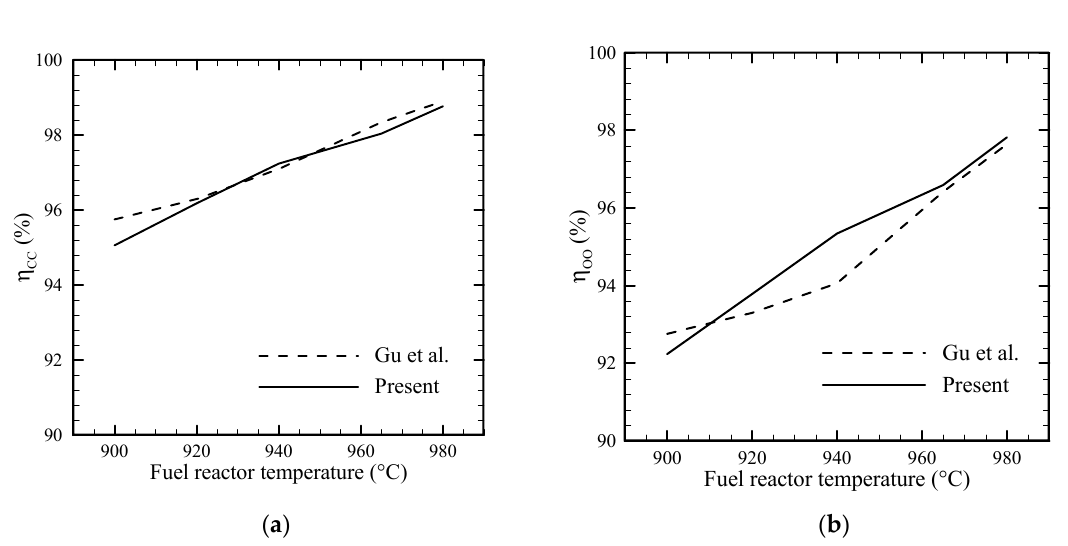
Figure 5. ( a ) Efficiency of carbon capture and ( b ) oxide oxygen fraction as a function of the temper- ature of the fuel reactor.